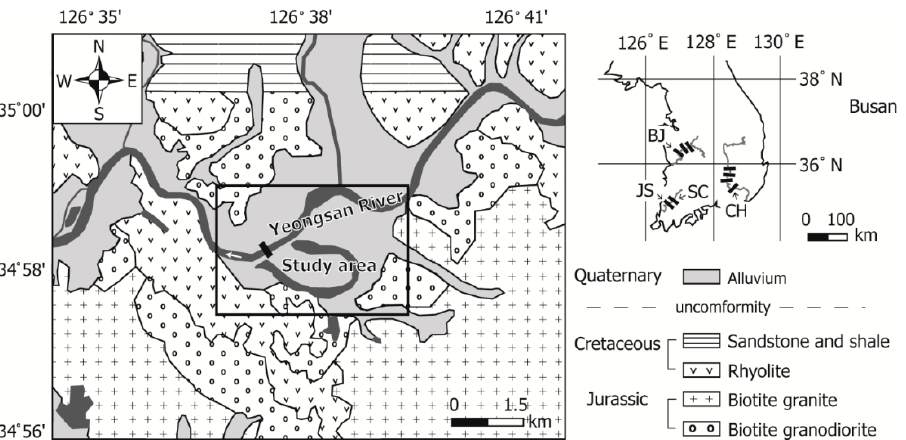
Figure 1. Location and geological map of the study area near the Juksan weir (JS) in the Yeongsan River Basin, South Korea (modified from [26]).